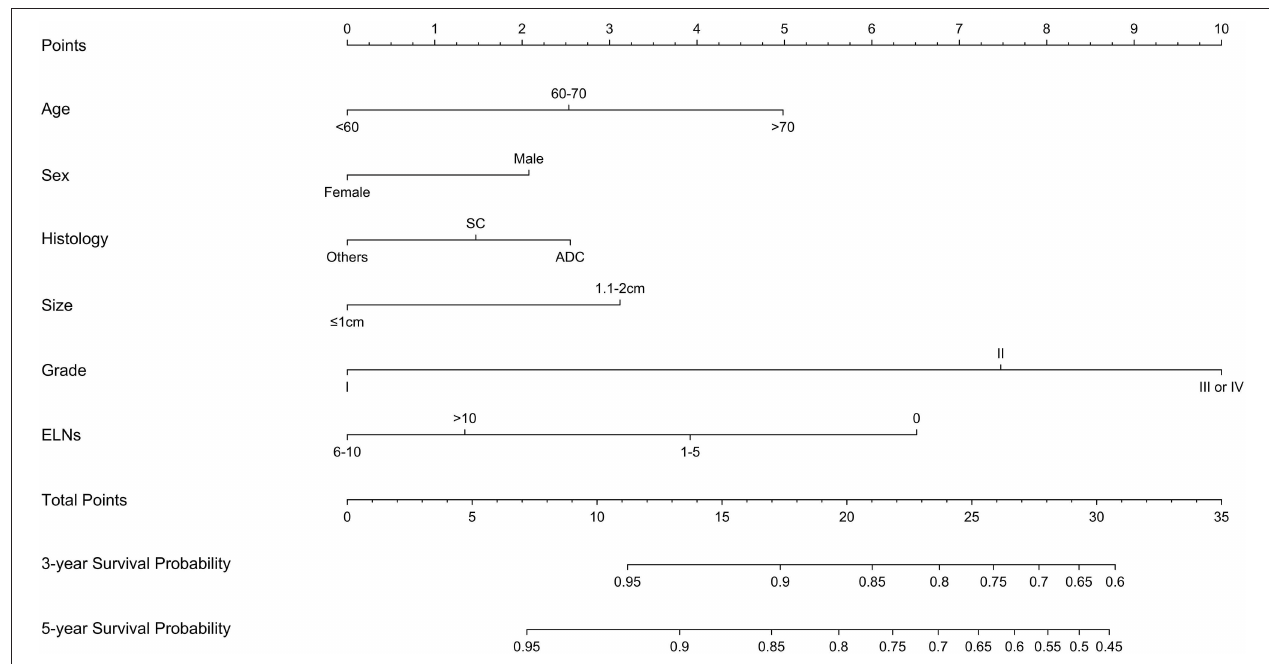
FIGURE 2 | Constructed nomogram for predicting survival in patients with stage IA non-small cell lung cancer ≤ 2cm undergoing sublobectomy. SC, squamous cell carcinoma; ADC, adenocarcinoma; ELNs, examined lymph